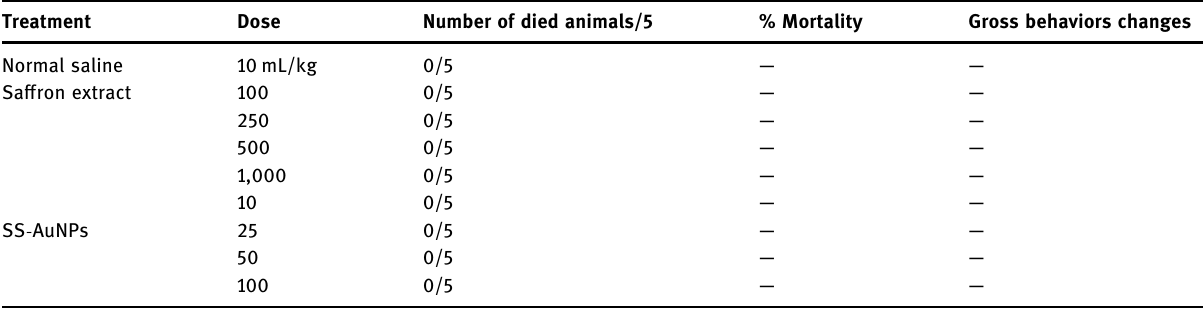
Table 7: Toxicological study of sa ff ron extract and AuNPs Treatment